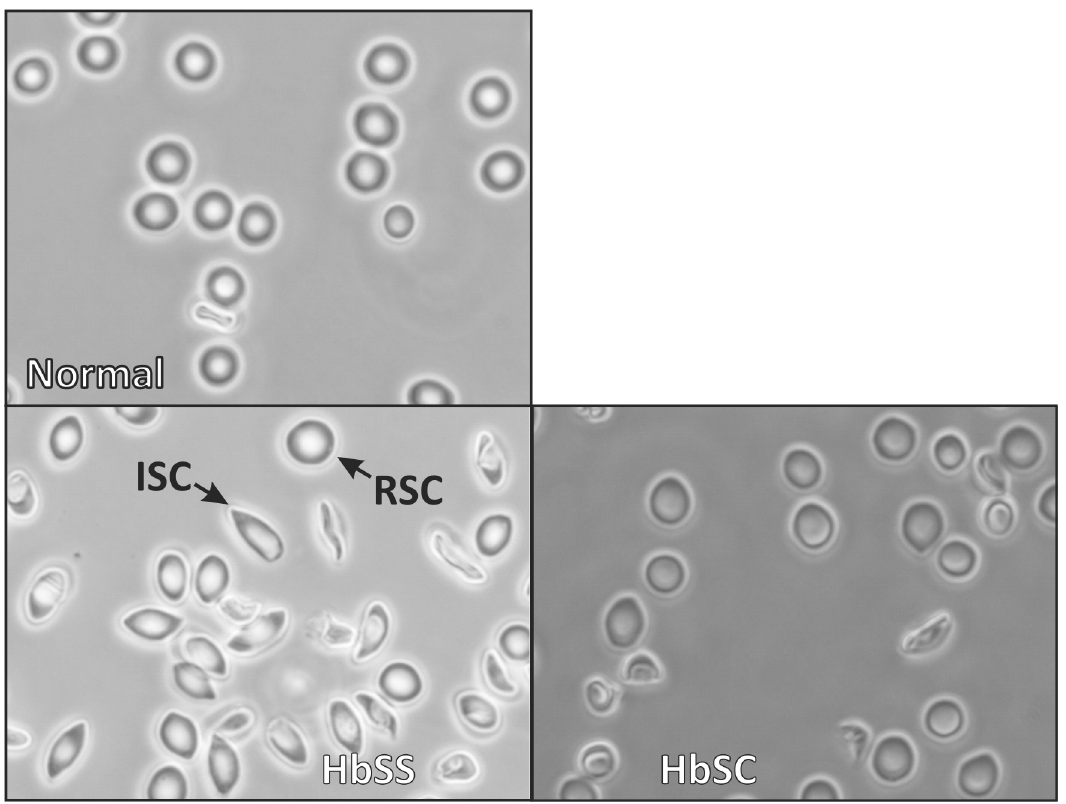
Fig 1. Representative differential interference contrast microscope images of erythrocytes examined in this study. Normal erythrocytes, erythrocytes from an HbSS patient with both reversibly sickled cells (RSC) and irreversibly sickled cells (ISC), and HbSC erythrocytes are shown in separate